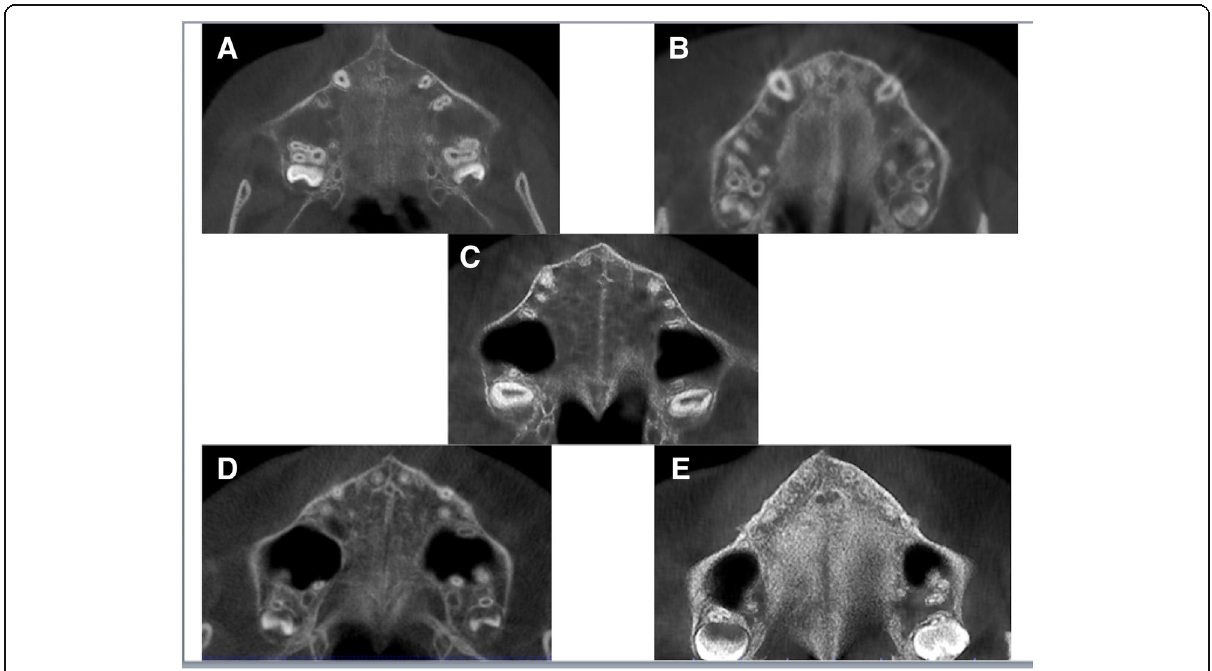
Fig. 2 The maturation stages of the midpalatal suture. a The midpalatal suture has no interdigitation. b The midpalatal suture shows an irregular shape. c The midpalatal suture is like as two parallel, scalloped, high-density lines. d Fusion of the midpalatal suture has occurred in the palatine bone. e Fusion of the midpalatal suture has also occurred in the